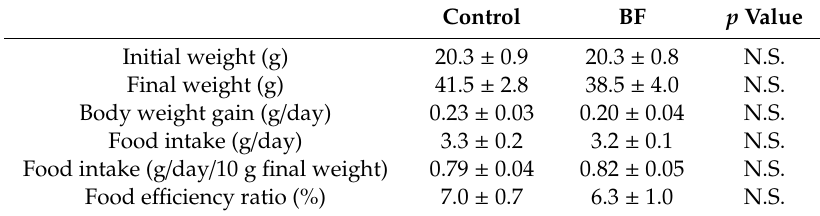
Table 3. Final weight, body weight gain, food intake, and food e ffi ciency ratio in mice fed the control and BF diets.